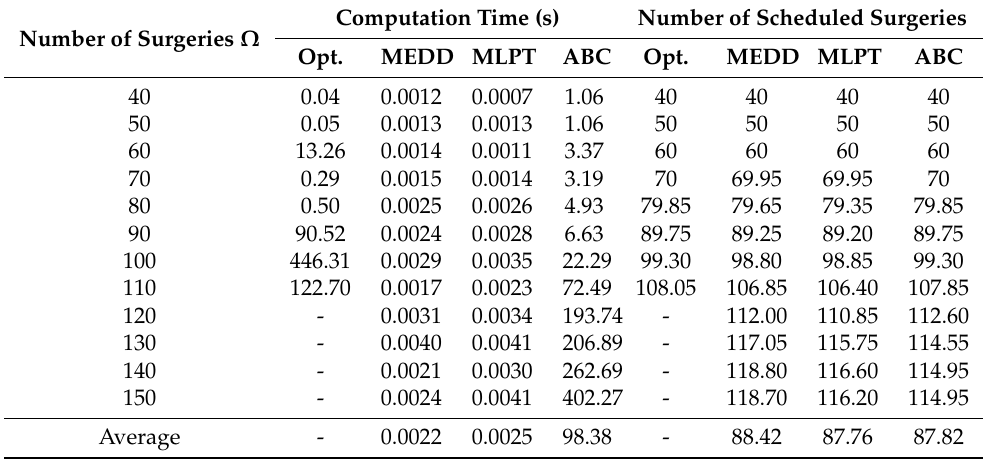
Table 4. The computational time of the MIP model, heuristics, and the ABC algorithm. Number of Surgeries